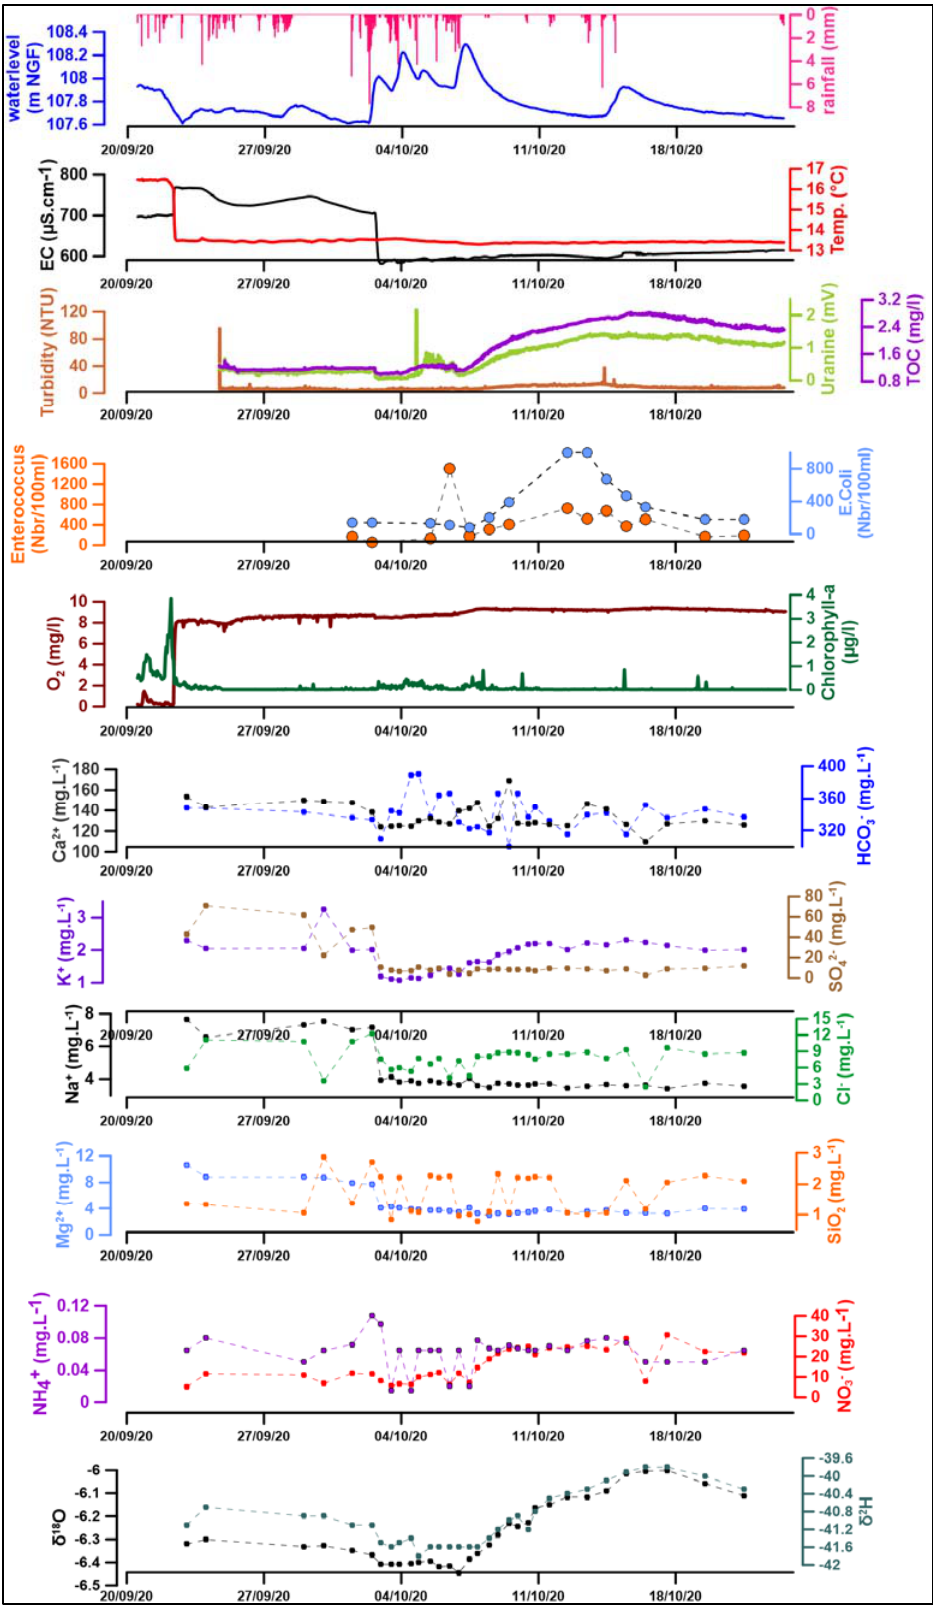
Figure B5. Chemiograph of the Saint Sauveur spring from 20/09/20 to 21/10/20. Figure A8. Chemiograph of the Saint Sauveur spring from 20/09/20 to